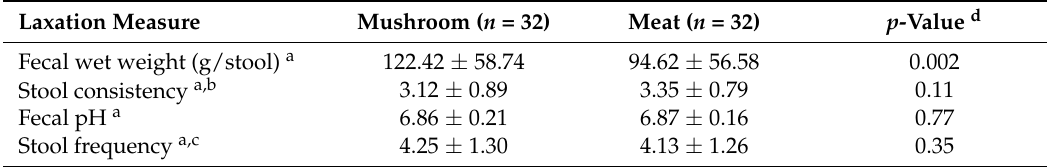
Table 7. Laxation Markers for fecal samples collected days 6 through 10.